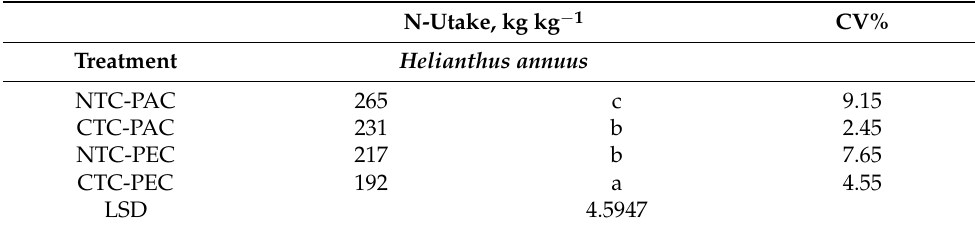
Table 6. N-uptake of the Helianthus annuus cultivation in the 4 different soil practice treatments in the second growing